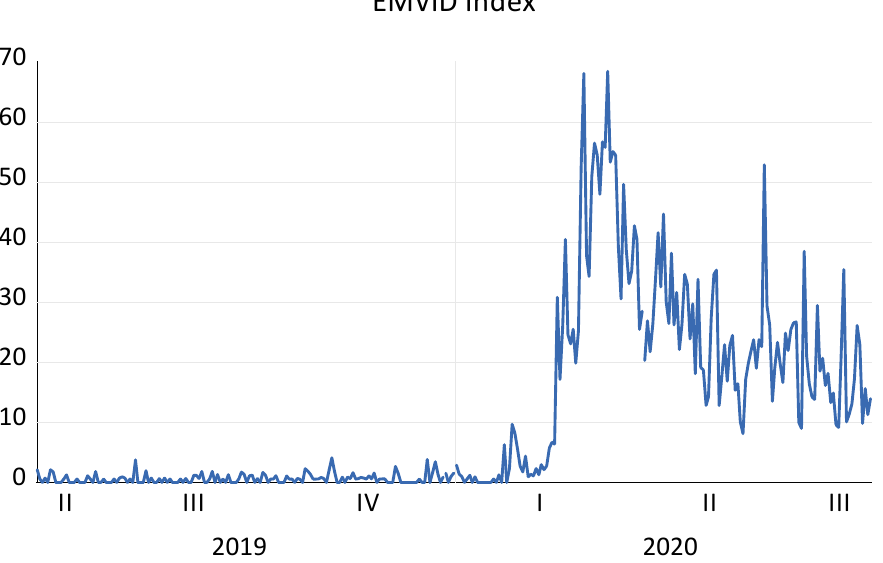
Figure 1. Plot of the EMVID Index. Source: Baker et al. (2020): http://policyuncertainty.com/infectious_EMV.html (accessed on 12 August 2020).